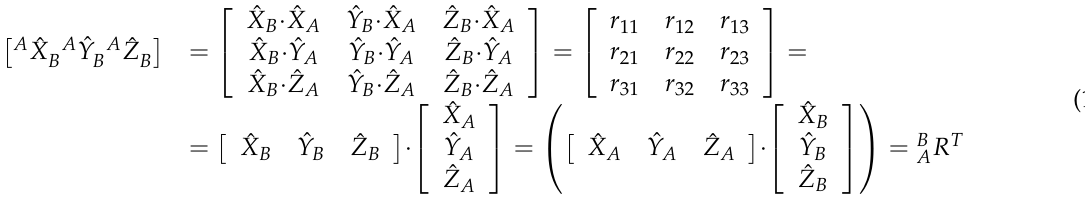
Figure 1. Coordinate systems { A } and { B } share the same origin; thus, one is a rotation of the other. A ˆ Y A ˆ Z [ A ˆ X ] denotes the three unit vectors of { B } described in the coordinate B B B system { A }. The rotation matrix between { A } and { B } is composed of an inner product of these unit